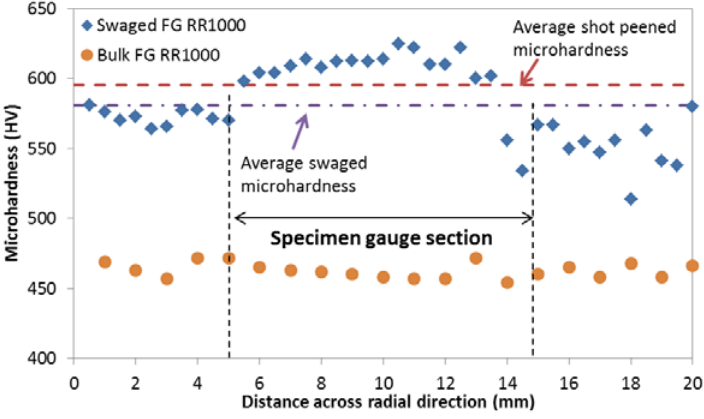
Figure 15. Micro-hardness measurements across radial sections of pre and post swaged bar materials.